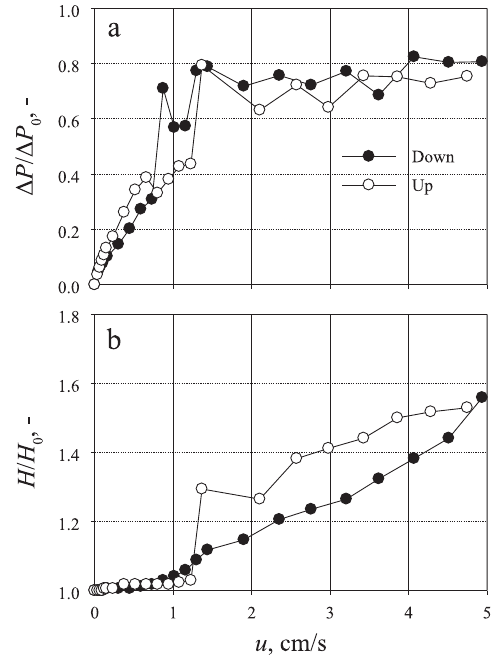
Fig. 12 (a) Dimensionless pressure drops and (b) bed expan - sion curves obtained in ordinary